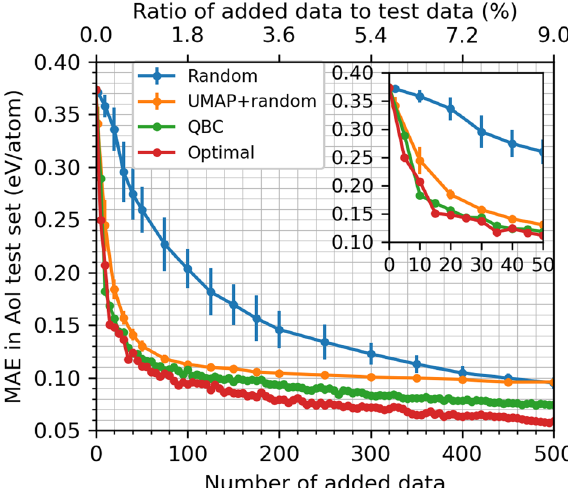
Fig. 10 Test MAE as a function of a number of selected test data added to the training set. The inset shows the enlarged region at the early stage of the active learning process. All the results are reported for the RF model. The random sampling and the UMAP- plus-random results are the averages of 10 runs with different random seeds, with the error bars indicating the standard